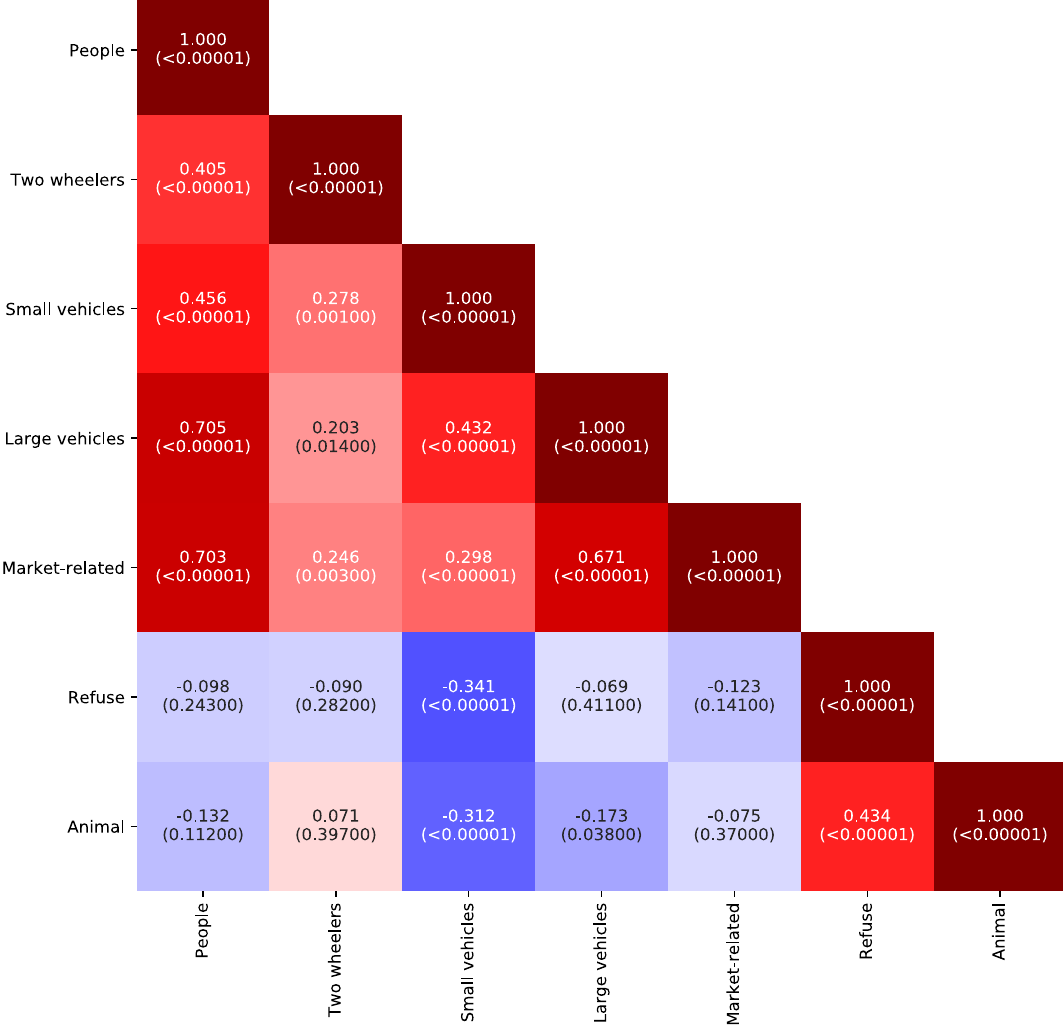
Figure 4. Co-occurrence of objects at measurement sites. The figure shows the Pearson correlation coefficient among pairs of object categories for average counts of objects per site, calculated across all cameras at all sites. For sites with two cameras the correlation coefficient was calculated for the average count across both cameras. The number in parentheses shows the p-value for the correlation coefficient. See Supplementary Fig. 3 for correlation coefficients calculated across images, i.e., co-occurrence in